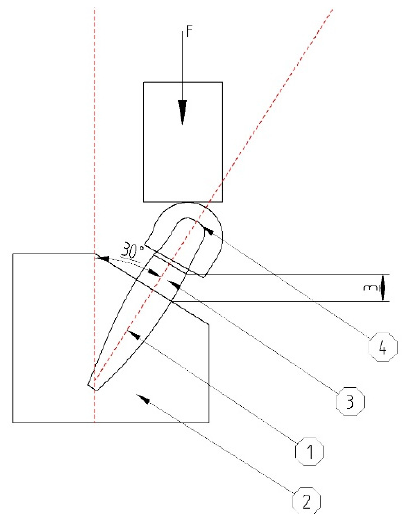
Figure 2. Scheme for mounting of the implant in the testing machine according to ISO 14801. The body of the implant ( 1 ) is mounted in a block, ( 2 ) bone in our case, with its coronal portion ( 3 ) 3 mm above the bone level. It is angled at 30 ◦ in order to stimulate less-than-optimal placing of the implant. The force is applied on a hemispherical cap covering the abutment ( 4 ) specially designed for this